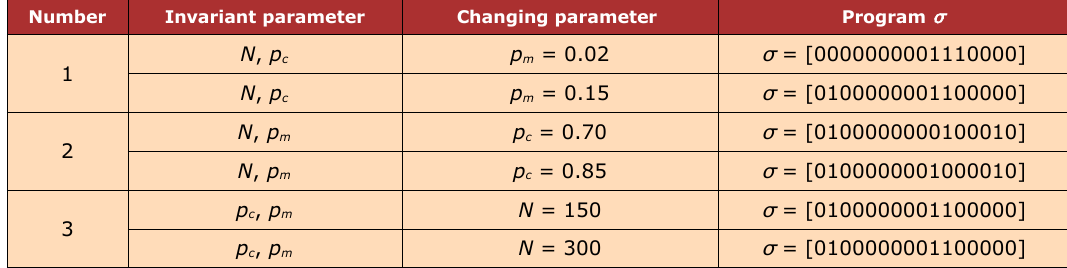
Table 5. Simulation results of change the parameter